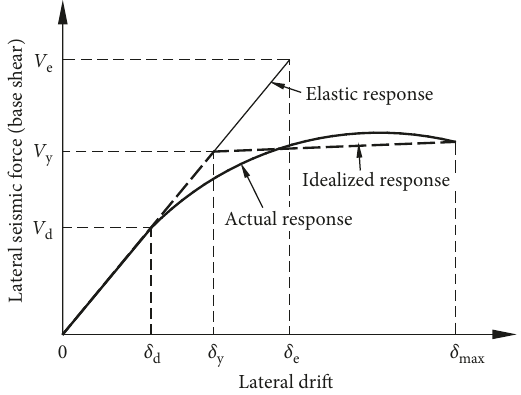
Figure 17: Illustration of seismic performance factors.